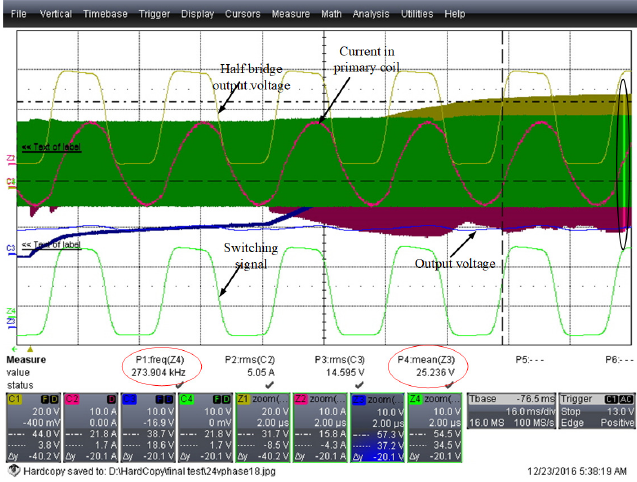
Figure 23. Waveform of controlling output 25